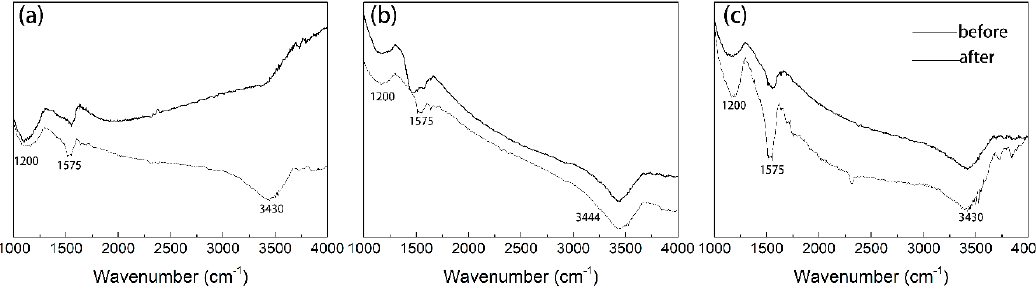
Figure 3. FTIR spectra of (a) GAC 950 , (b) PAC 800 , and (c) PAC 1000 before and after phenol adsorption .